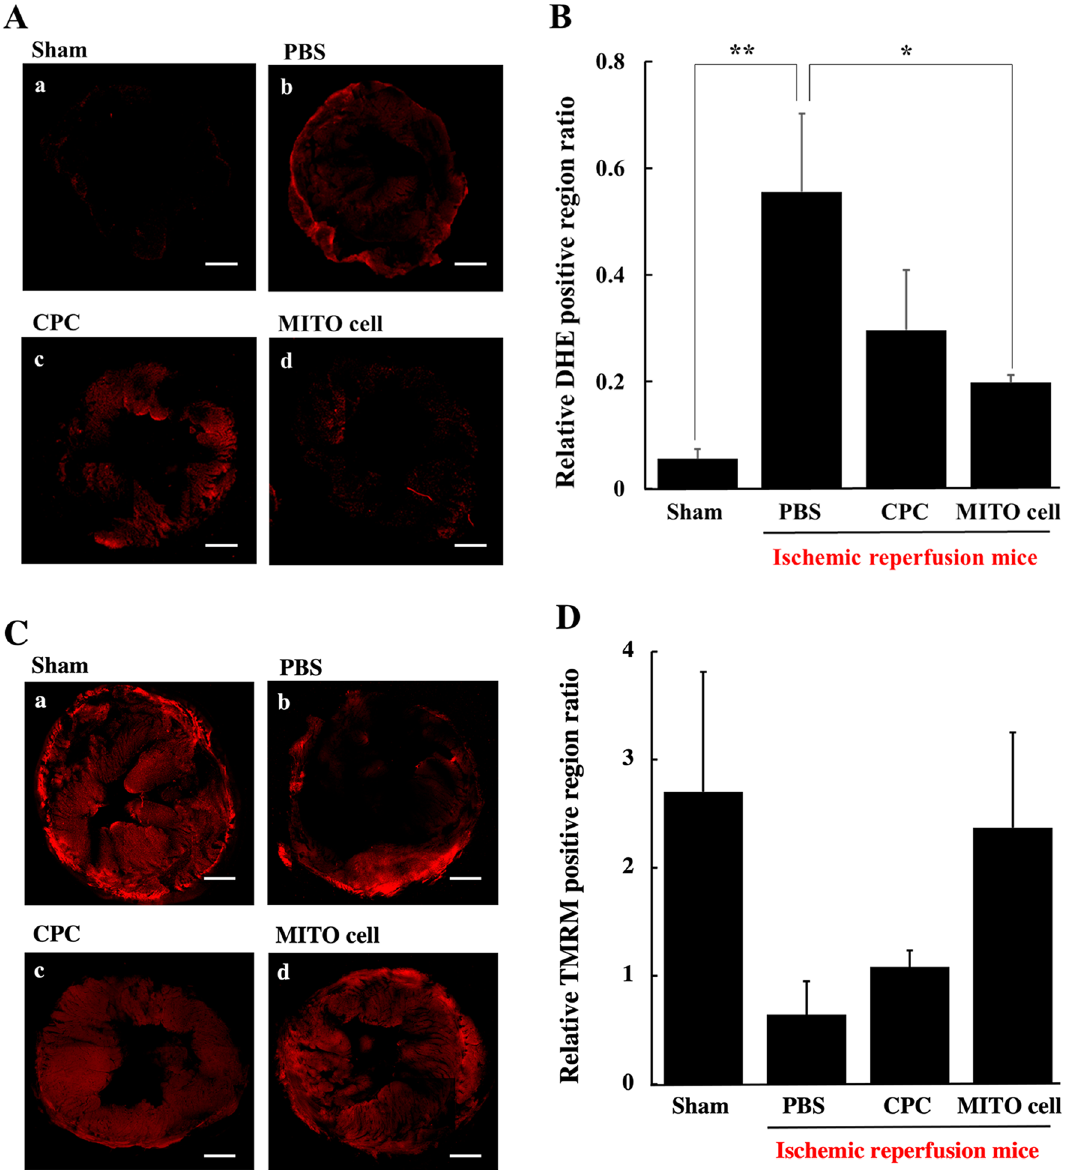
Figure 7. Detection of oxidative stress of ischemic myocardium after cell transplantation. ( A ) CLSM observation of oxidative stress of ischemic myocardium 3 days after treatment in each group using DHE (a red dye for reactive oxygen spices). ( a ) Sham group, ( b ) PBS group, ( c ) CPC transplantation group and ( d ) MITO-cell transplantation group. Scale bars, 200 μm. ( B ) Quantification of relative DHE positive region ratio was estimated using CLSM images. Data are represented as the mean ± S.D (sham group (n = 6), PBS group (n = 4), CPC transplantation group (n = 4) and MITO-cell transplantation group (n = 4)). Significant differences (*p < 0.05, **p < 0.01) were calculated by one-way ANOVA, followed by SNK test. Scale bar is 200 μm. Detection of mitochondrial membrane potential of ischemic myocardium after cell transplantation. ( C ) CLSM observation of mitochondrial membrane potentials of ischemic myocardium 3 days after treatment in each group using TMRM (a red dye for mitochondrial membrane potential). ( a ) Sham group, ( b ) PBS group, ( c ) CPC transplantation group and ( d ) MITO-cell transplantation group. Scale bars 200 μm. ( D ) Quantification of relative TMRM positive region ratio was estimated using CLSM images. Data are represented as the mean ± S.D (sham group (n = 6), PBS group (n = 5), CPC transplantation group (n = 5) and MITO-cell transplantation group (n = 5)). Significant differences (*p < 0.05, **p < 0.01) were calculated by one-way ANOVA, followed by SNK